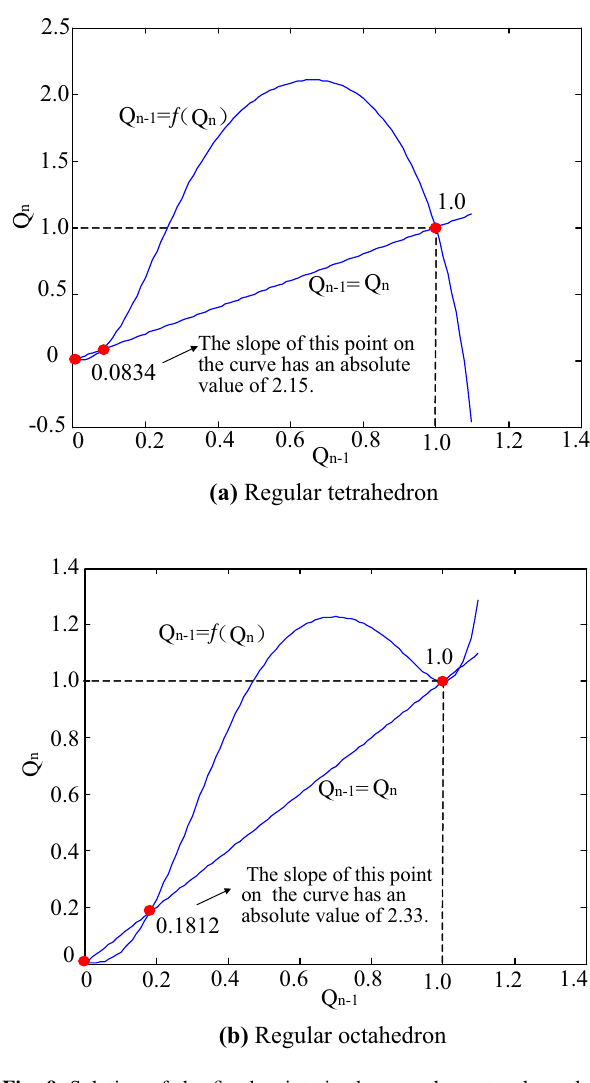
The slope of this point on the curve has an absolute 0.0834 value of 2.15.